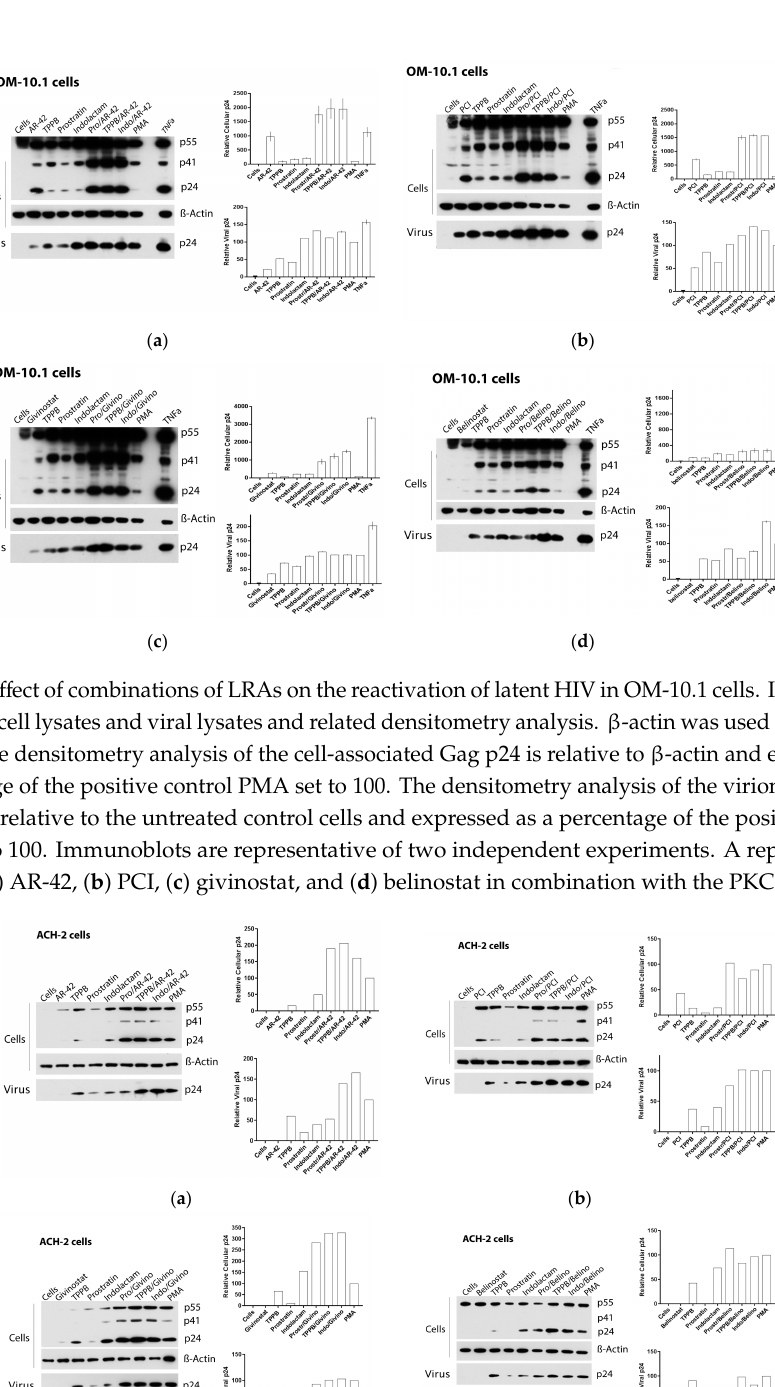
( f ) Figure 4. Combinations of LRAs reactivate latent HIV measured using HIV RNA quantification. ( a , b ) OM-10.1, ( c , d ) ACH-2, and ( e , f ) U1 cells were treated with LRAs alone or in combination for 48 h. OM-10.1 positive control cells were treated with PMA or TNF α . U1 and ACH-2 positive control cells were treated with PMA. The cell-associated (intracellular) and virus-associated (extracellular) HIV RNA was detected using qRT-PCR and expressed as a percentage of the positive control PMA set to 100 (black columns). Gray columns represent cells treated with TNF α ; red columns are cells treated with prostratin in combination with or without HDACis; green columns are cells treated with TPPB in combination with or without HDACis; blue columns are cells treated with indolactam in combination with or without HDACis; and white columns are cells treated with a single HDACi. Data are shown as mean ± S.D. of three independent experiments.